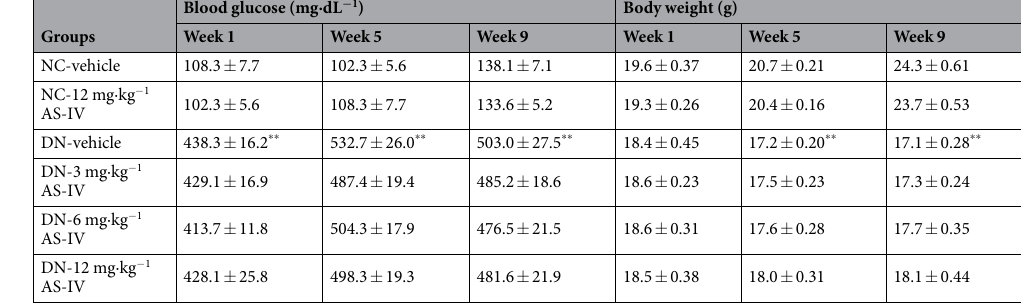
Table 1. Fasting blood glucose and body weight during the treatment period. 8-week-old C57BL/6 J mice were injected intraperitoneally with 100 mg·kg − 1 STZ for 2 consecutive days in the first week (week 0). 1 week after STZ injection (week 1), the mice were treated with AS-IV at the indicated doses of AS-IV for 8 consecutive weeks. Data are expressed as mean ± SEM. n = 8–12 per group. ** P < 0.01 compared to NC-vehicle group. One-way ANOVA and Newman-Keuls multiple comparisons test. NC, nondiabetic control. DN, diabetic